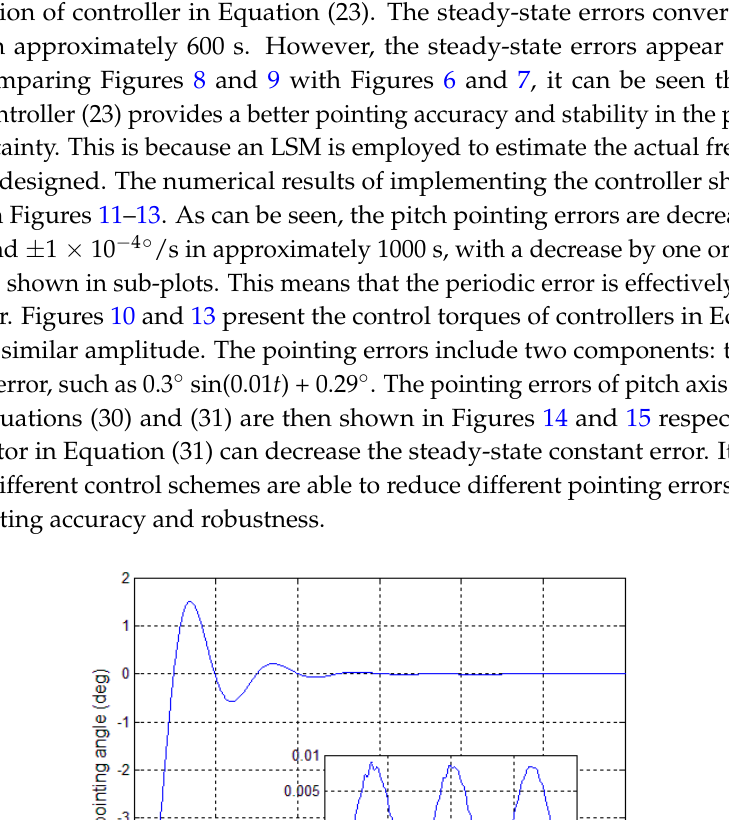
Figure 7. Antenna pitch angular velocity error—controller (13).